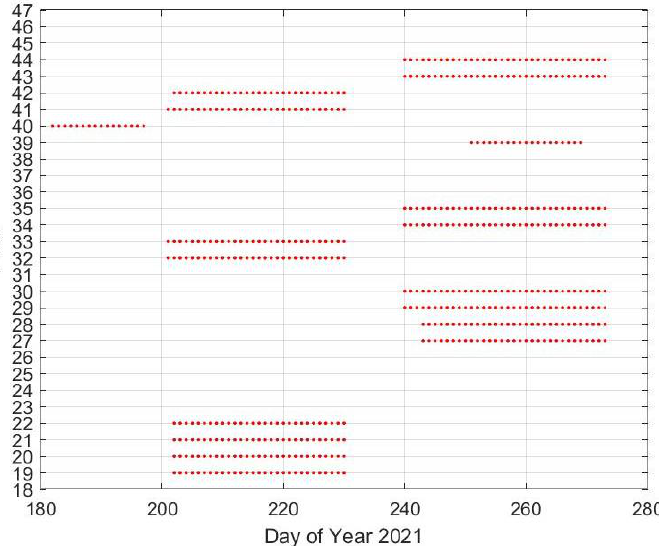
Figure 5. Eclipse seasons for the BDS-3 satellites (1 July 2021 to 30 September 2021, red dots represent eclipse seasons).